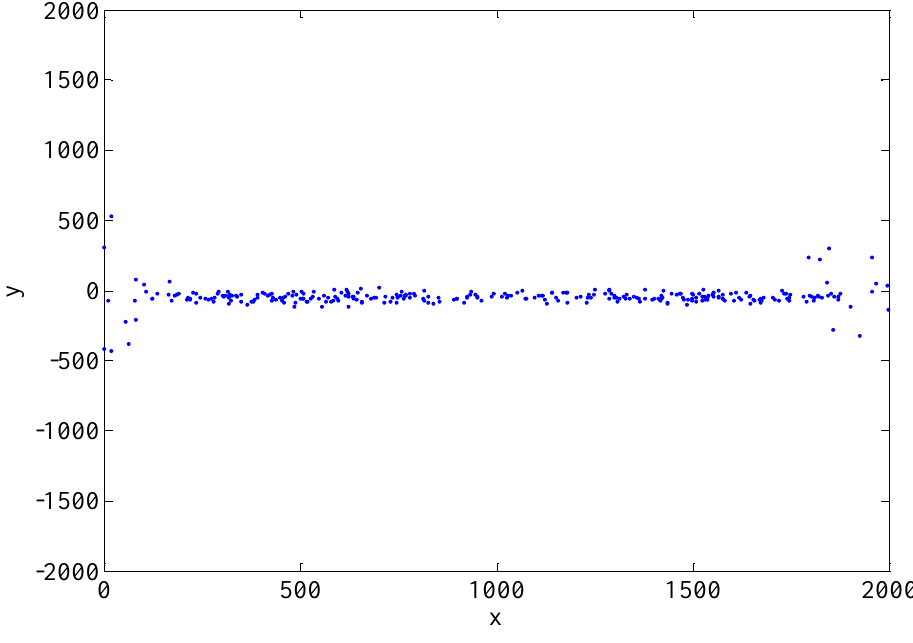
Figure 13. Distribution of the divergence points for